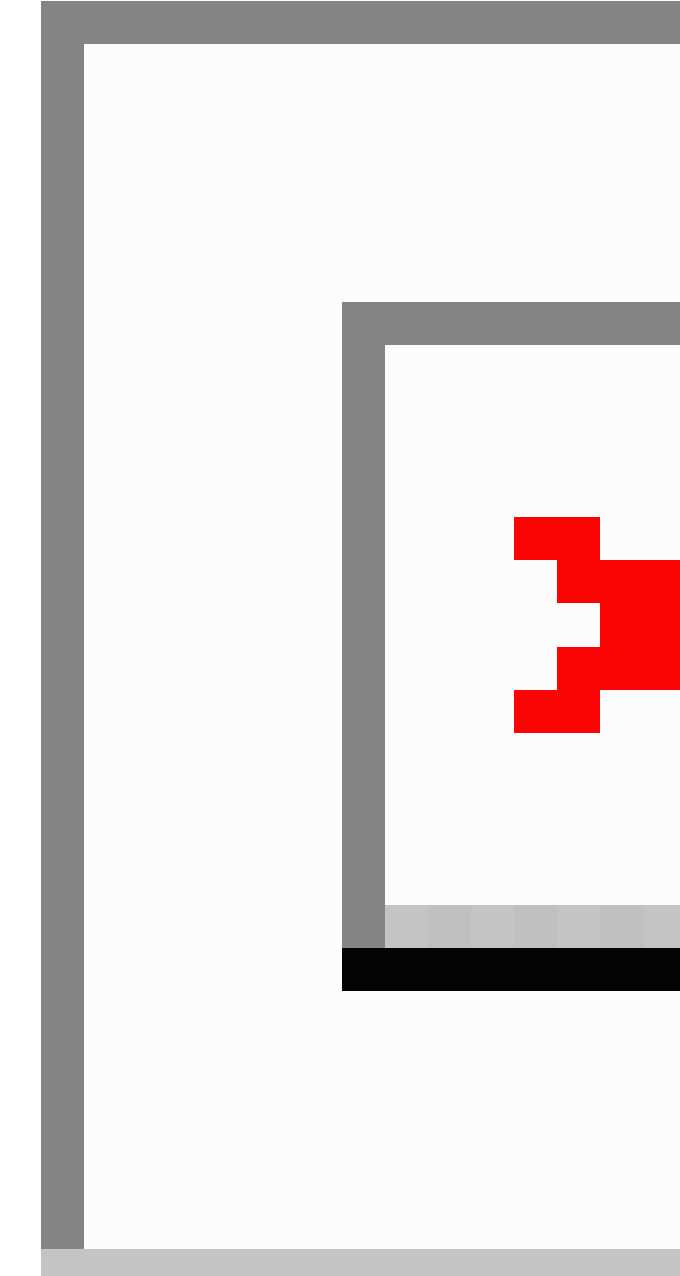
Figure 1. Risk communication presented to participants in prototype